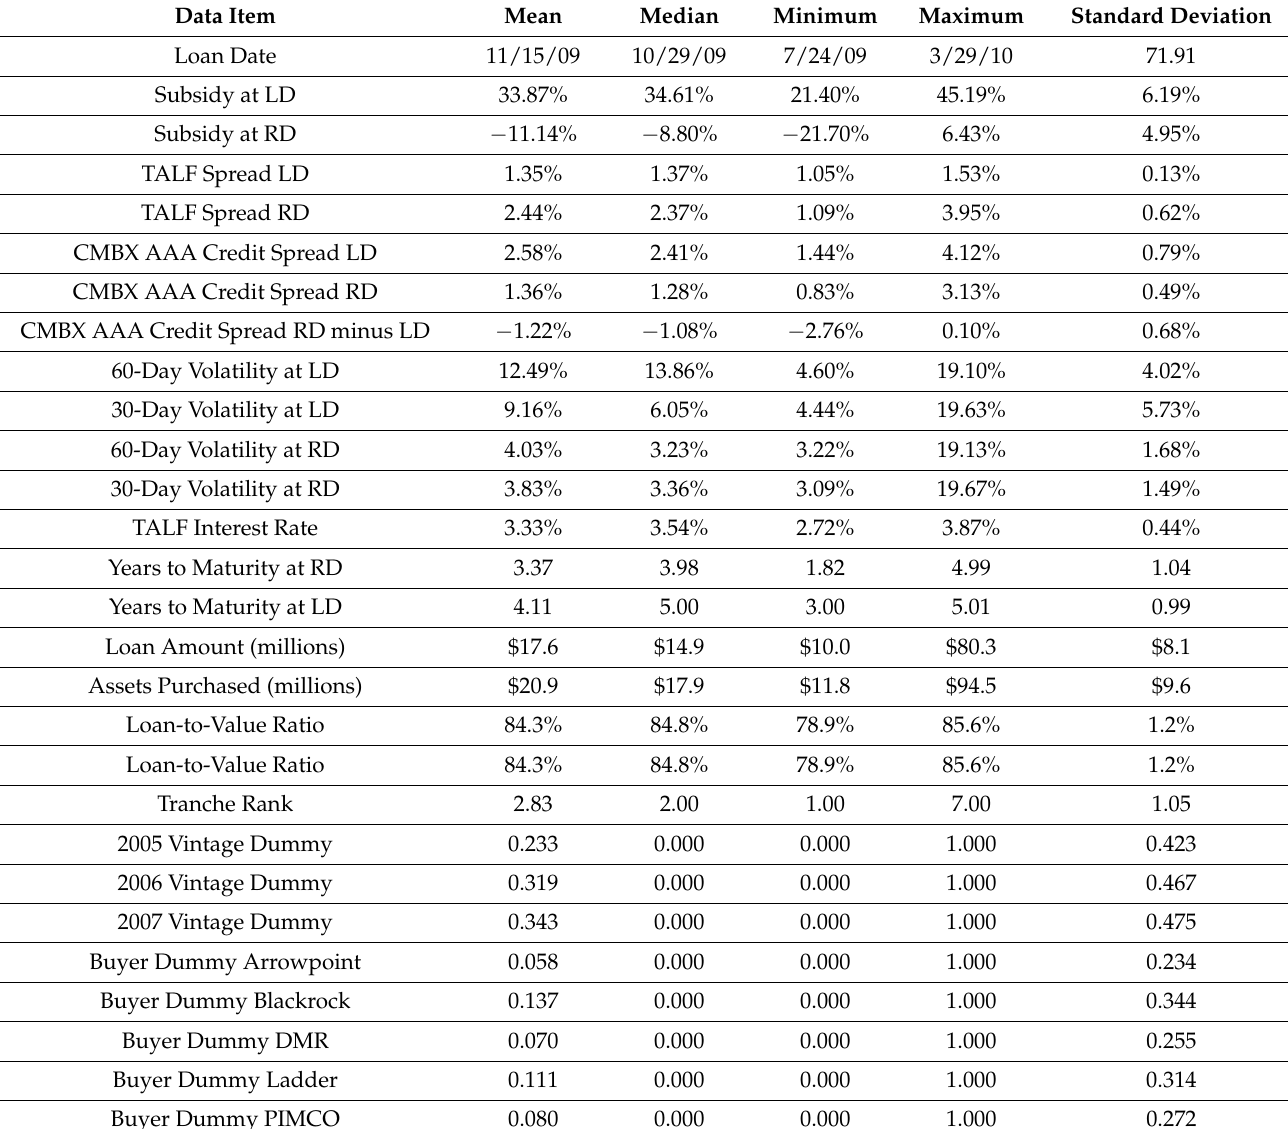
Table 1. Summary